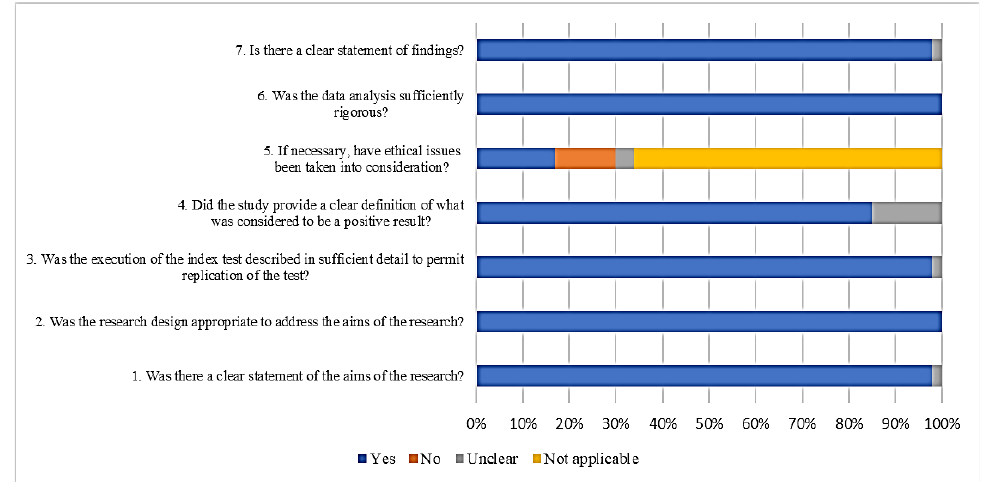
Figure 1. PRISMA-ScR flow diagram showing the process of selecting studies.